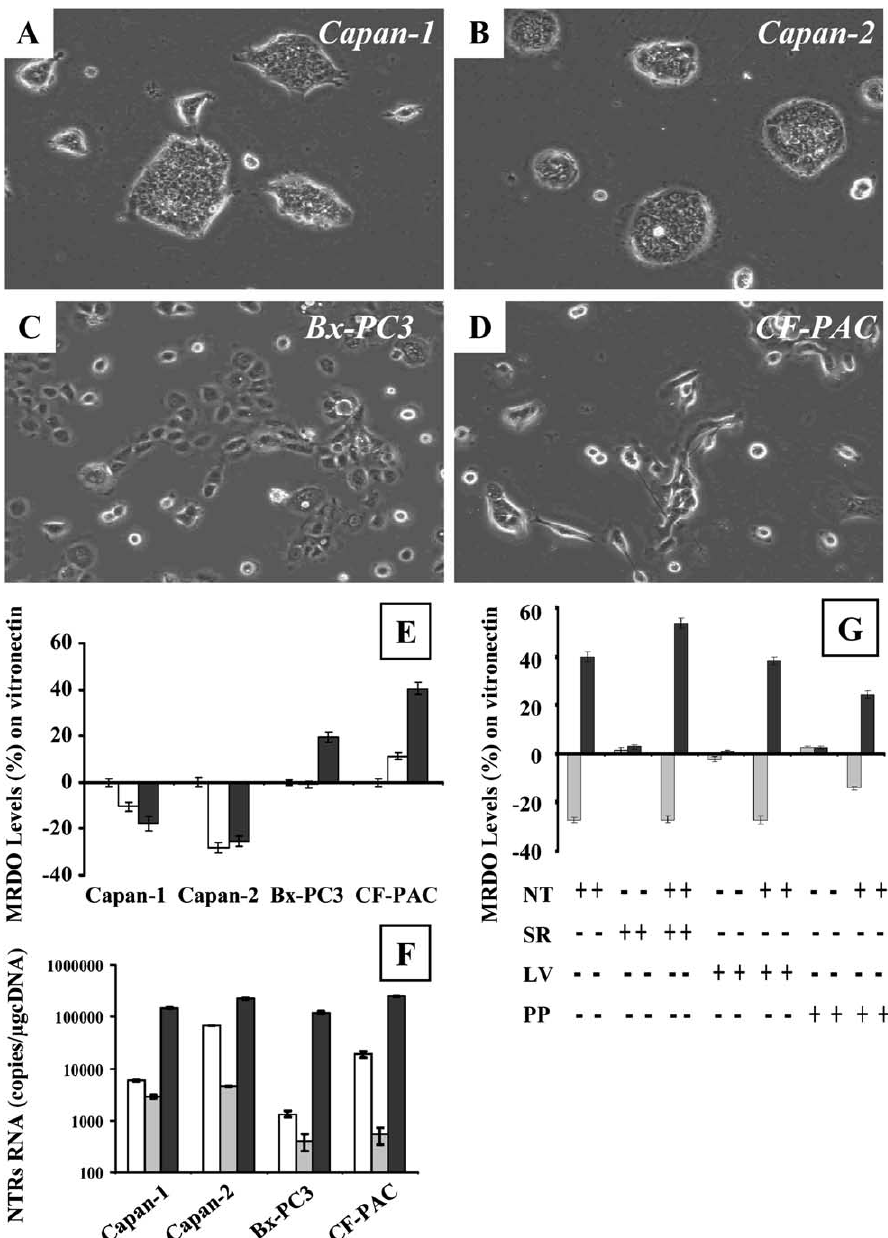
Fig. 1. (A–D) Illustrations of the different migratory behavior patterns encountered with the four human PDAC lines studied: collective in the case of Capan-1 (A) and Capan-2 (B) versus individual in the case of Bx-PC3 (C) and CF-PAC (D). (E) The effects on the motility (MRDO variable) of the PDACs cultured on vitronectin (0.1 µ g/cm 2 ) due to NT treatment at 0.1 nM (open bars) and 10 nM (black bars). The data are reported as means ± SEM expressed in percentages of variation as compared to control (arbitrarily set at 0%). (F) Evaluation by means of the real-time RT-PCR of the mRNA expression of NTR1 (open bars), NTR2 (gray bars) and sortilin/NTR3 (black bars) in four human PDAC cell lines (logarithmic scale). (G) Similarly to Fig. 1E, the 10 nM NT-induced effects on Capan-2 (gray bars) and Bx-PC3 (black bars) cell motility observed on a vitronectin coating without pre-treatment, or after pre-treatment with the NTR1 antagonist (SR48692, indicated as SR; 1 µ M), the NTR2 antagonist (levocabastine, indicated as LV; 1 µ M) and the sortilin/NTR3 antagonist pro-propeptide (indicated as PP; 1 µ